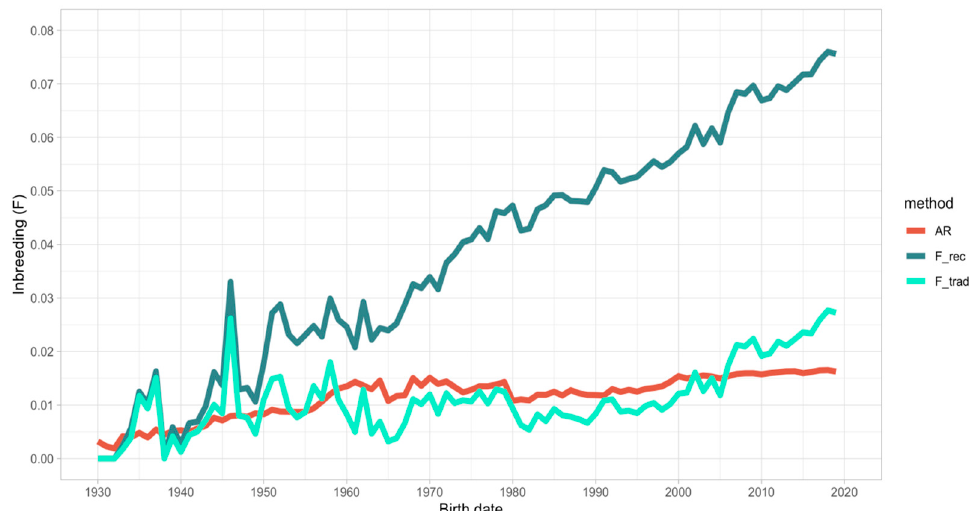
Figure 1. Trend of average relatedness (AR), traditional (F_trad), and recursive (F_rec) inbreeding in the last 90 years.